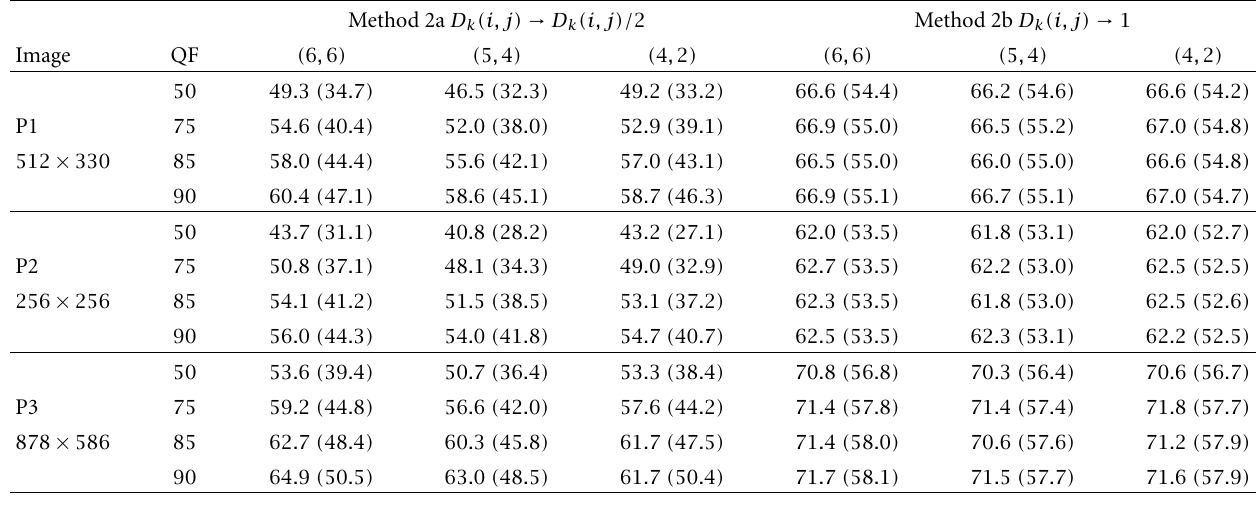
Table 3: PSNR for embedding a 128-bit message and for a 4000-bit message (in parenthesis) for three test images, four quality factors, and three different DCT coefficients.